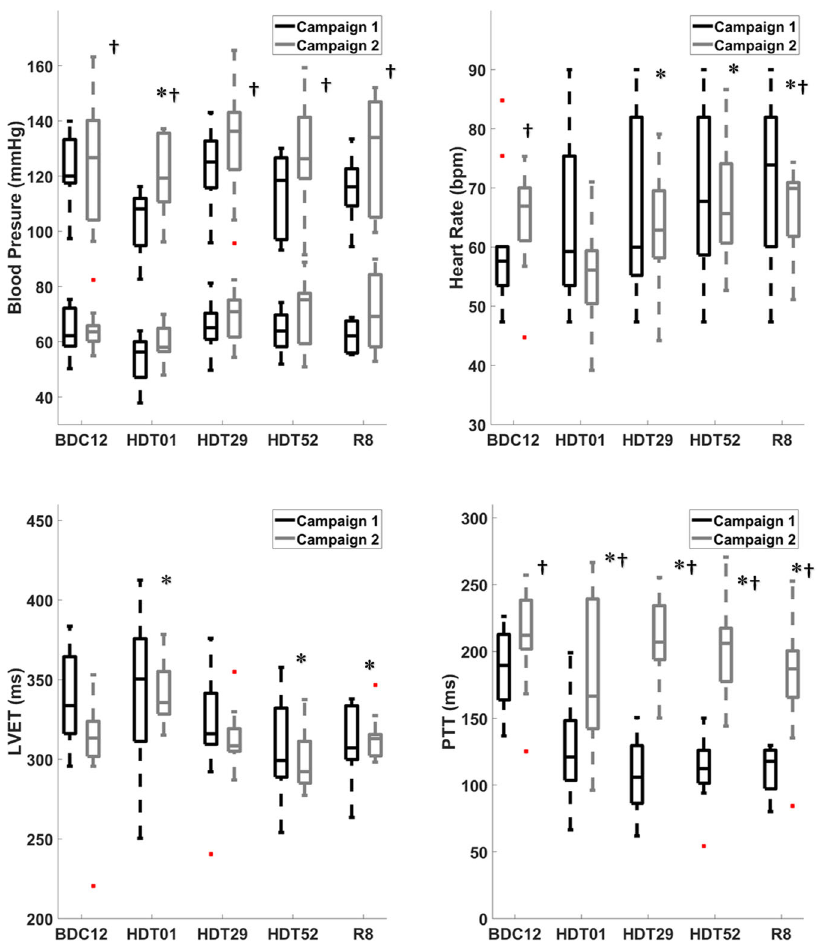
Fig. 4 Cardiovascular function through the three phases of bed rest. Cardiovascular timing intervals of PTT and LVET were taken from the relationships of SCG and show decreasing trends. PTT has a drastic average decrease that does not recover after 8 days post bed rest. LVET has a variable adjustment to fl uid shifts of bed rest but decreases towards the end with a slight recovery. Blood pressure values adjust to fl uid shifts with an initial decrease but stabilize towards the end of bed rest. Upper values in the plot represent systolic BP and lower values, diastolic BP. Boxes represent ± 1 interquartile range, whiskers represent ± 1.5 interquartile range and center lines are medians. * Denotes signi fi cant differences compared to BDC12 and † denotes signi fi cance between campaigns at each test day ( p <